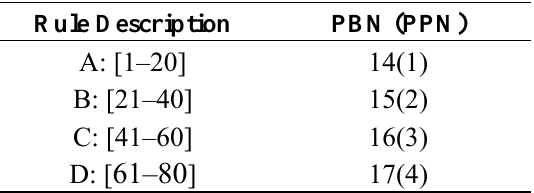
Table 3. Mapping table in